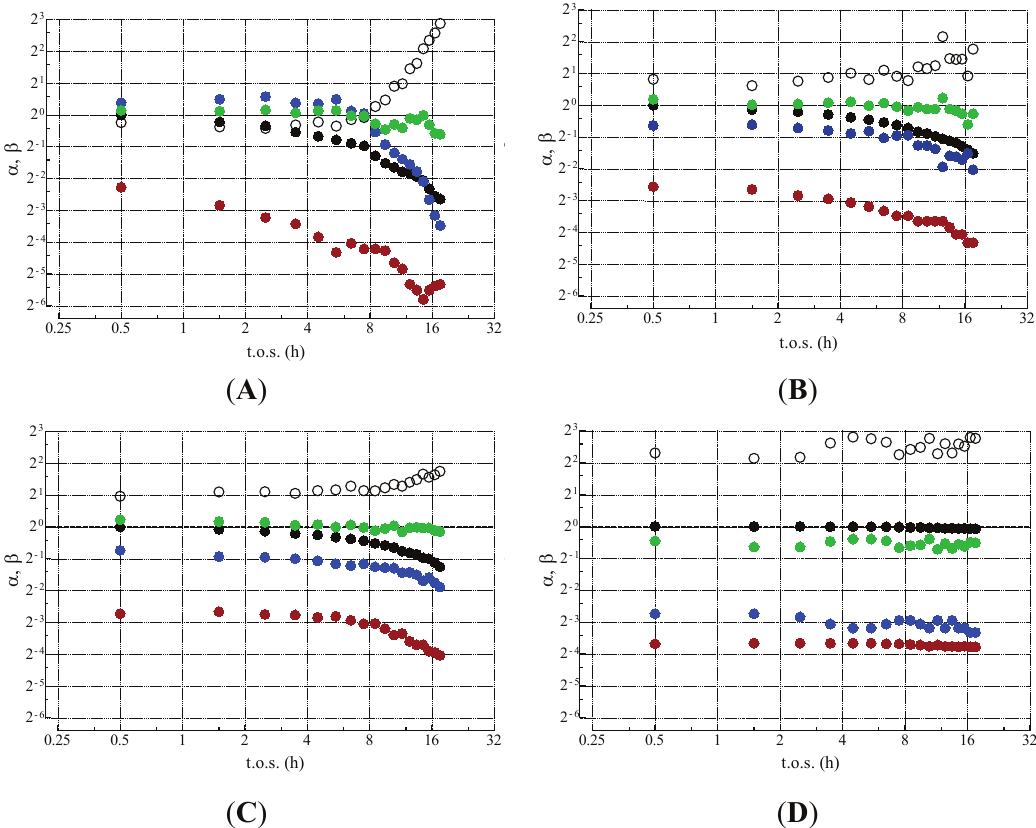
Figure 7. Pre-reforming of the n -hexane ( T , 450 °C; P , 10 bar). Effect of S/C ratio and H feeding on α and β values of GAS, WGS, MET and DISP reactions vs. t.o.s.: ( A ) S/C, 1.5; H /C, 0; ( B ) S/C, 2.8; H /C, 0; ( C ) S/C, 3.5; H /C, 0; ( D ) S/C, 2.8; H 2 2 2 (  ) β ; (  ) β ; (  ) β ; (  ) β (reproduced from ref. [11] with the kind WGS DISP GAS MET permission of Elsevier, copyright